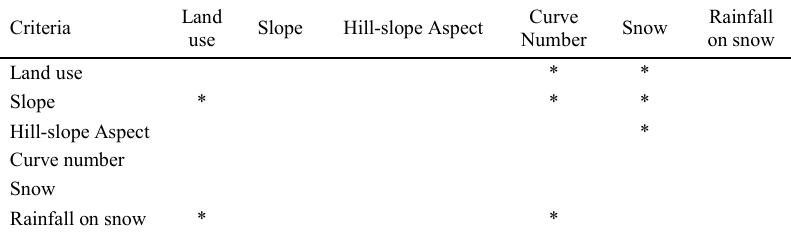
Table 5: Inner dependences for criteria in the network model to estimate the spatial potential of flooding based on the ANP